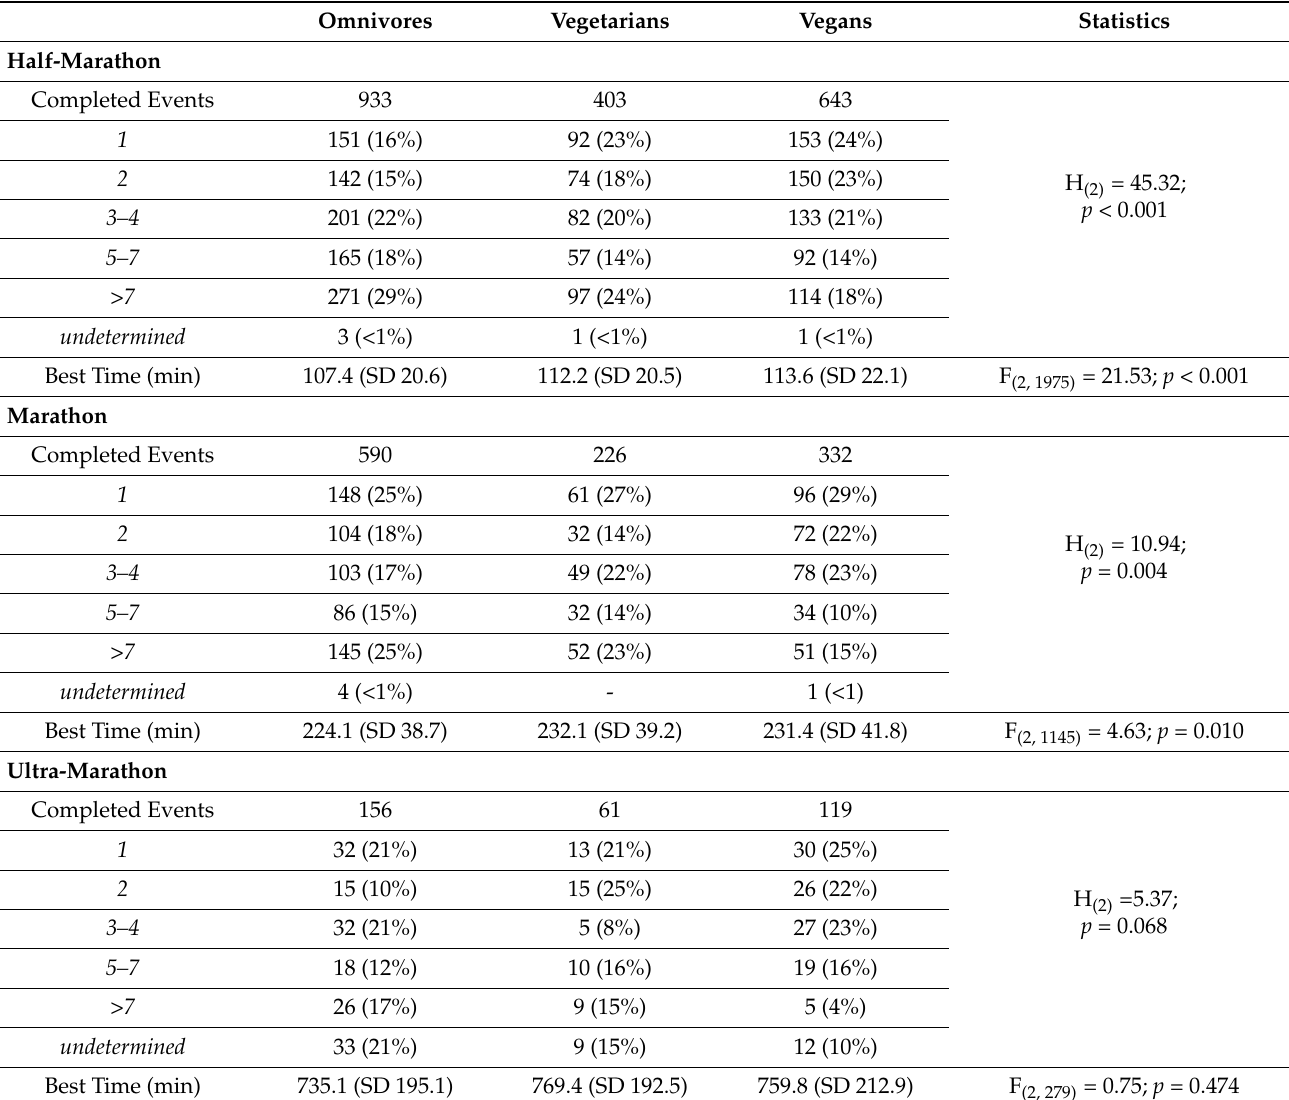
Table 6. Total numbers of completed half-marathon, marathon, and ultra-marathon events. The best time is displayed by dietary subgroups in minutes (mean ± standard